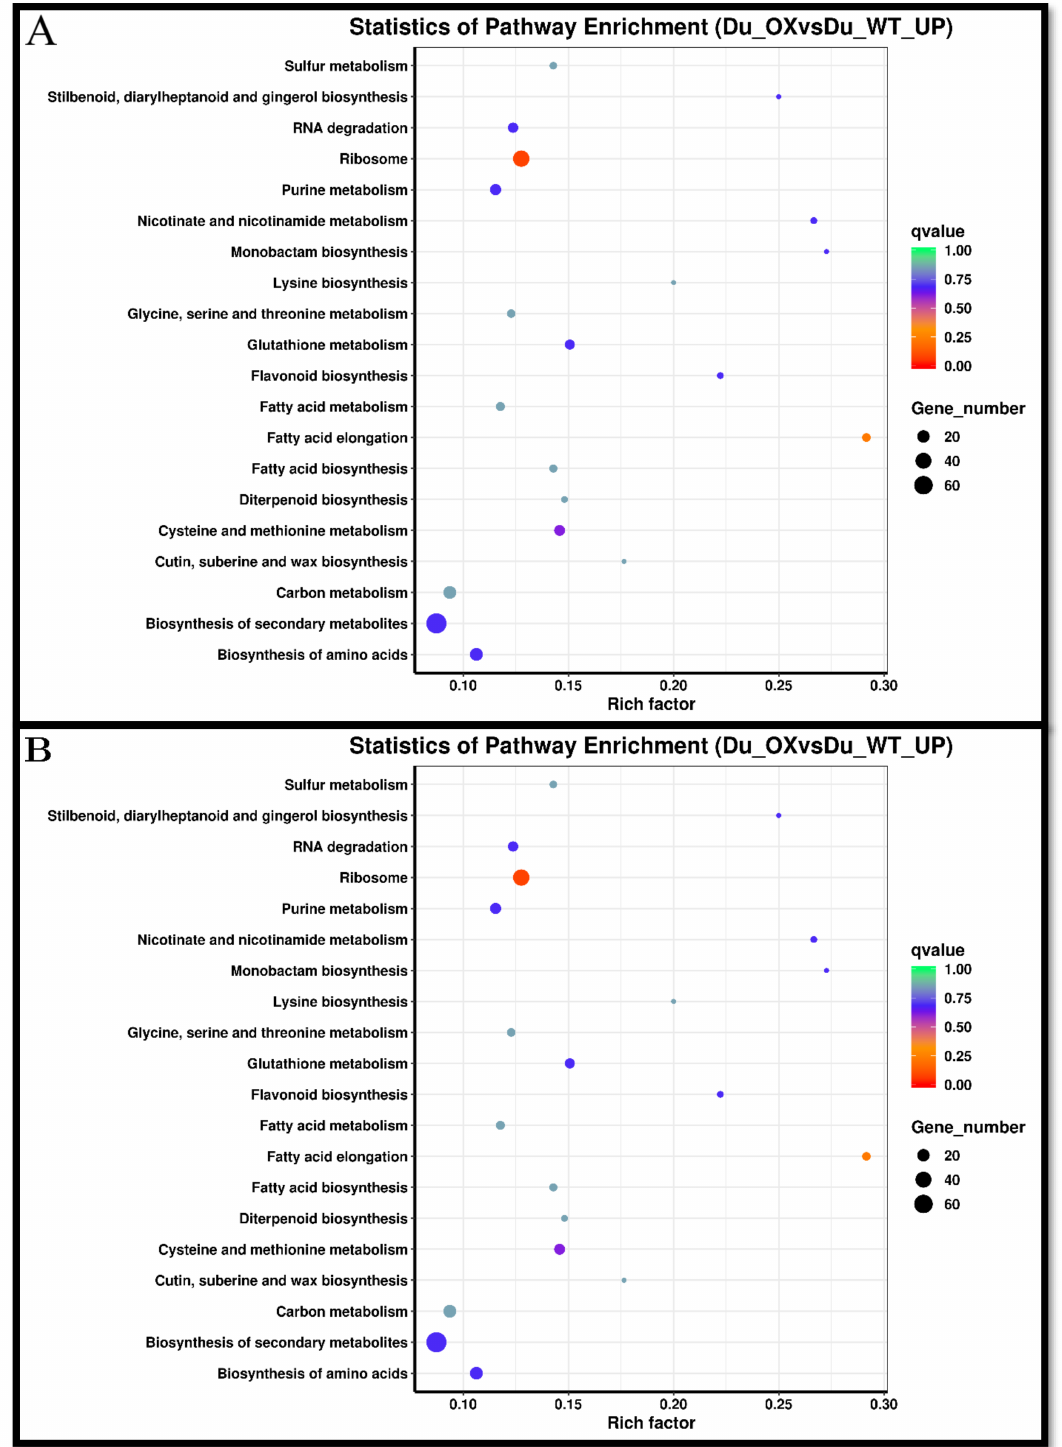
Figure 7. Kyoto Encyclopedia of Genes and Genomes pathway enrichment scatter plot of up-regulated genes in the DU-OE line ( A ) and Kyoto Encyclopedia of Genes and Genomes pathway enrichment scatter plot of down-regulated genes in the DU-OE line ( B